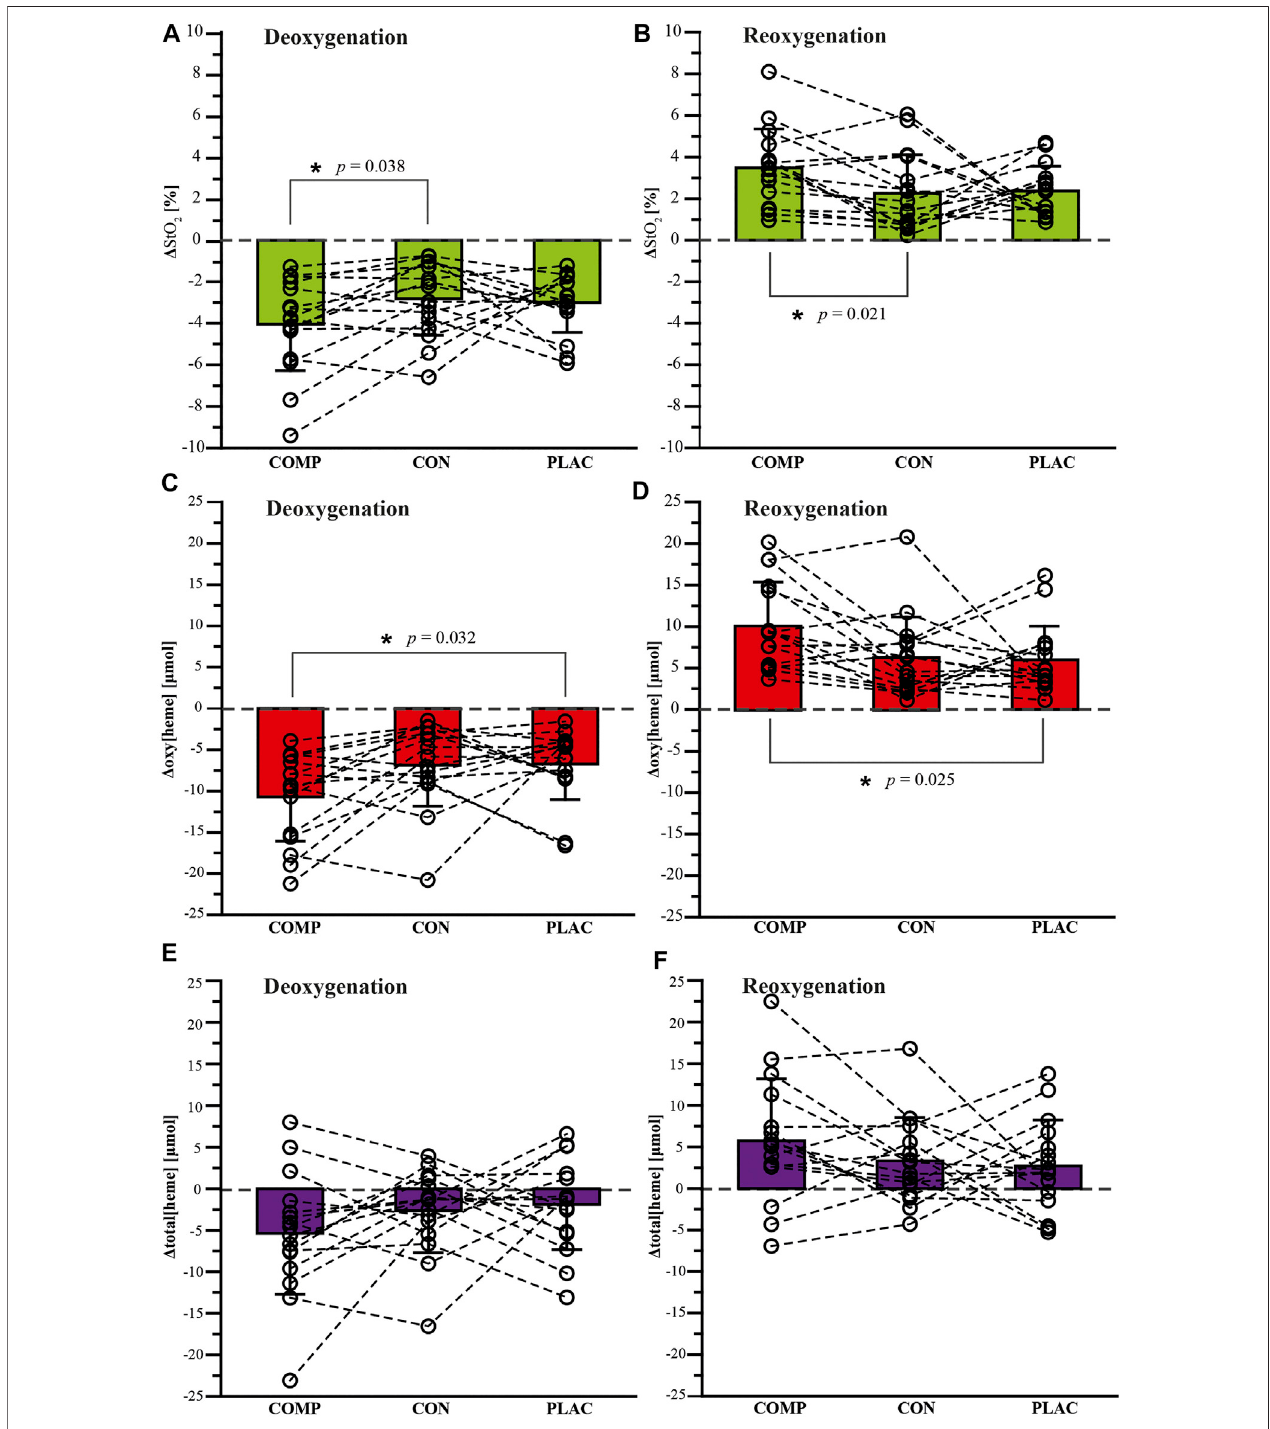
FIGURE 3 | Near-infrared spectroscopy (NIRS) changes during hand grip strength and endurance measurements ( n = 16) under compression (COMP), control (CON), and placebo (PLAC) conditions for: (A,B) tissue oxygen saturation ( Δ StO 2 ), (C,D) oxygenated ( Δ oxy[heme]), and (E,F) total (total [heme]) [heme]. Data points represent individual values ( ○ ). Bar charts are means ± SD. See the Section 2 for further details, * p < 0.05.